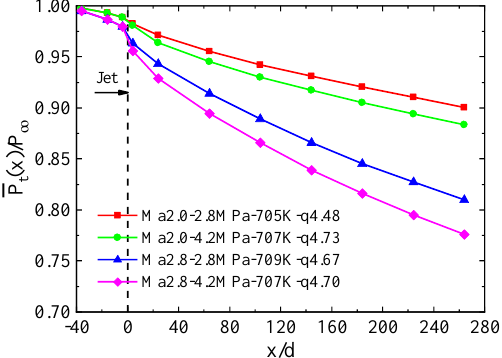
Figure 18. Total pressure recovery coefficient at different Ma.